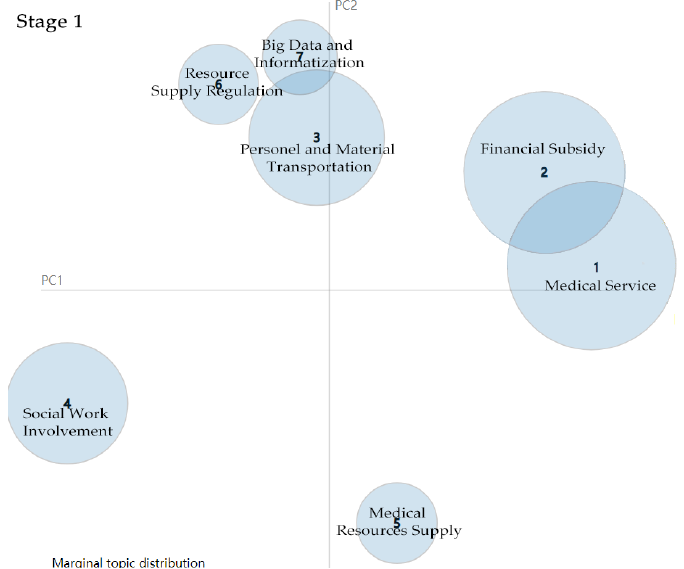
Figure 4. Topic intensity in Stage 1.